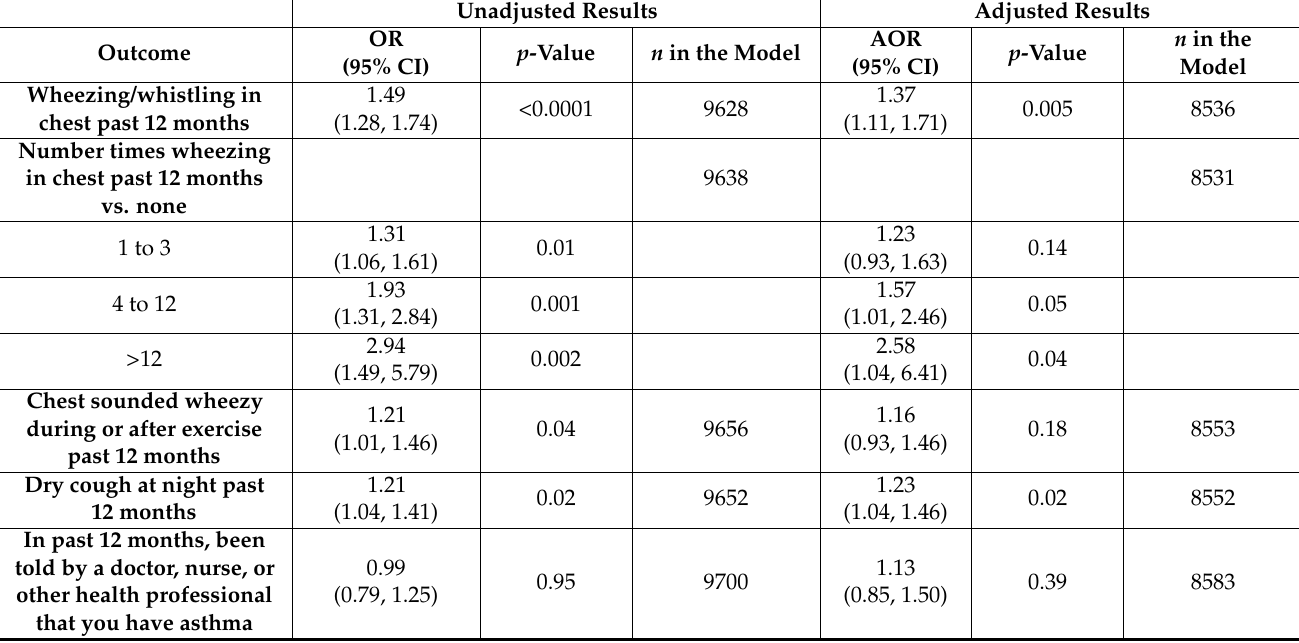
Table 2. Unadjusted and adjusted association between electronic nicotine product use in past 12 month and respiratory outcomes ( n = 9769).